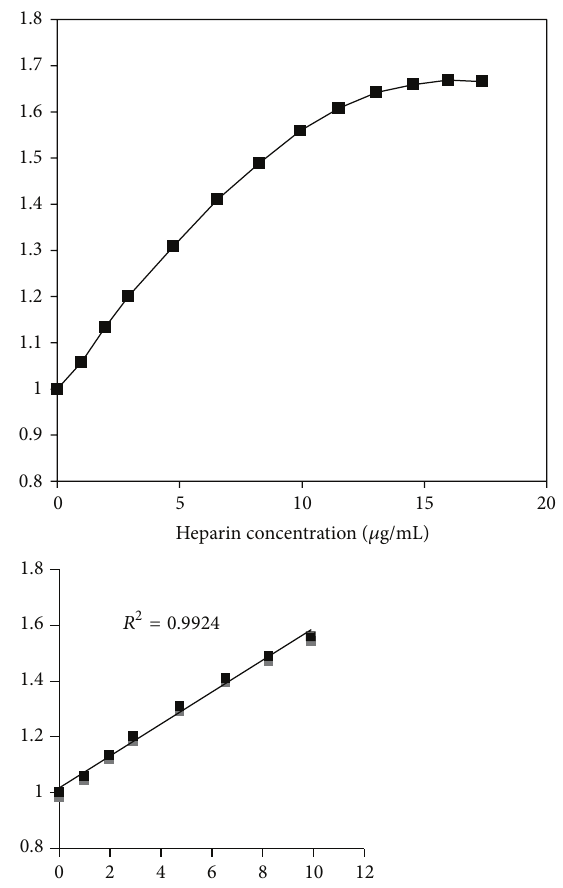
Figure 8: Stern-Volmer plot for the heparin quenching of the luminescence of [Os(phen) 2 CO(PPh 3 )](PF 6 ) 2 aqueous solution (1.2mg/100mL in H 2